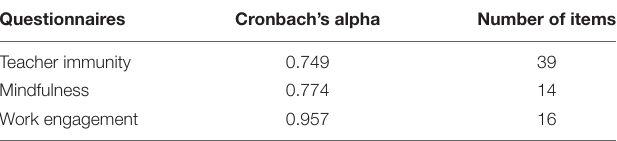
TABLE 2 | Reliability of the questionnaires. Questionnaires